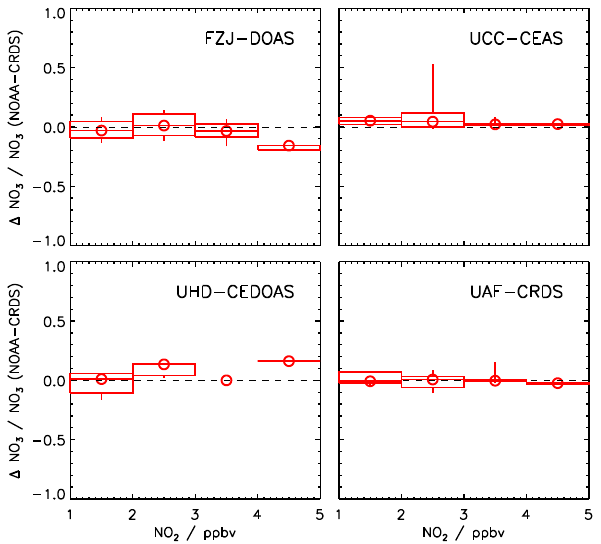
Fig. 9. Box-and-whisker plot of the relative difference of NO 3 mea- surements between various instruments and the reference NOAA- CRDS as function of the NO 2 mixing ratio during the chamber ex- periment on 9 June. Dots are medians, boxes give the first and third quartile and whiskers denote the 10th and 90th percentiles.